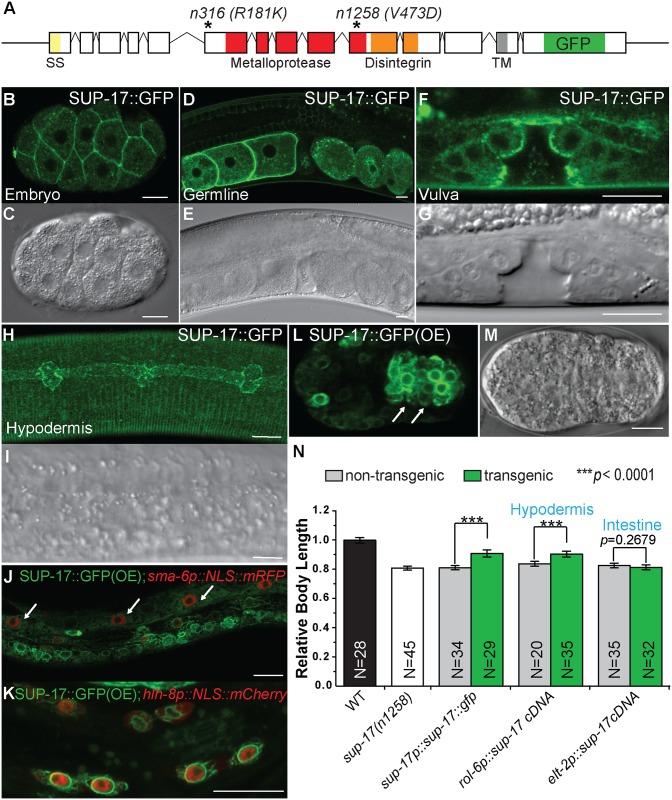
SUP-17 is localized both to the cell surface and in the cytoplasm in multiple cell types, including known Sma/Mab signal-receiving cells.(A) A schematic of the sup-17 genomic region (not to scale), depicting the location of various protein domains, the GFP insertion site and the location of the n1258 and n316 molecular lesions. (B-I) Confocal fluorescent images (B, D, F, H) and corresponding DIC images (C, E, G, I) of transgenic worms expressing endogenous SUP-17::GFP (B, D, F, H) in the early embryo (B), gravid adult gonad (D), L4 developing vulva (F) and L3 hypodermis (H). (J) An L3 transgenic animal carrying both over-expressed SUP-17::GFP and sma-6p::NLS::mRFP, showing expression of SUP-17::GFP in the hypodermal cells (arrows). (K) An L1 transgenic animal carrying both over-expressed SUP-17::GFP and the M lineage specific reporter hlh-8p::nls::mCherry at the 16-M stage. Some M lineage cells are out of the focal planes shown. (L-M) GFP (L) and DIC (M) images of a mid-stage transgenic embryo carrying over-expressed SUP-17::GFP, showing GFP expression in the intestinal precursor cells (marked by arrows). Anterior is to the left. Scale bars represent 10μm in B-M. (N) Rescue of the small body size of sup-17(n1258) worms by tissue-specific sup-17 cDNA expression. The mean body length of WT worms is normalized to 1.0. Error bars represent 95% confidence intervals for the normalized body length.